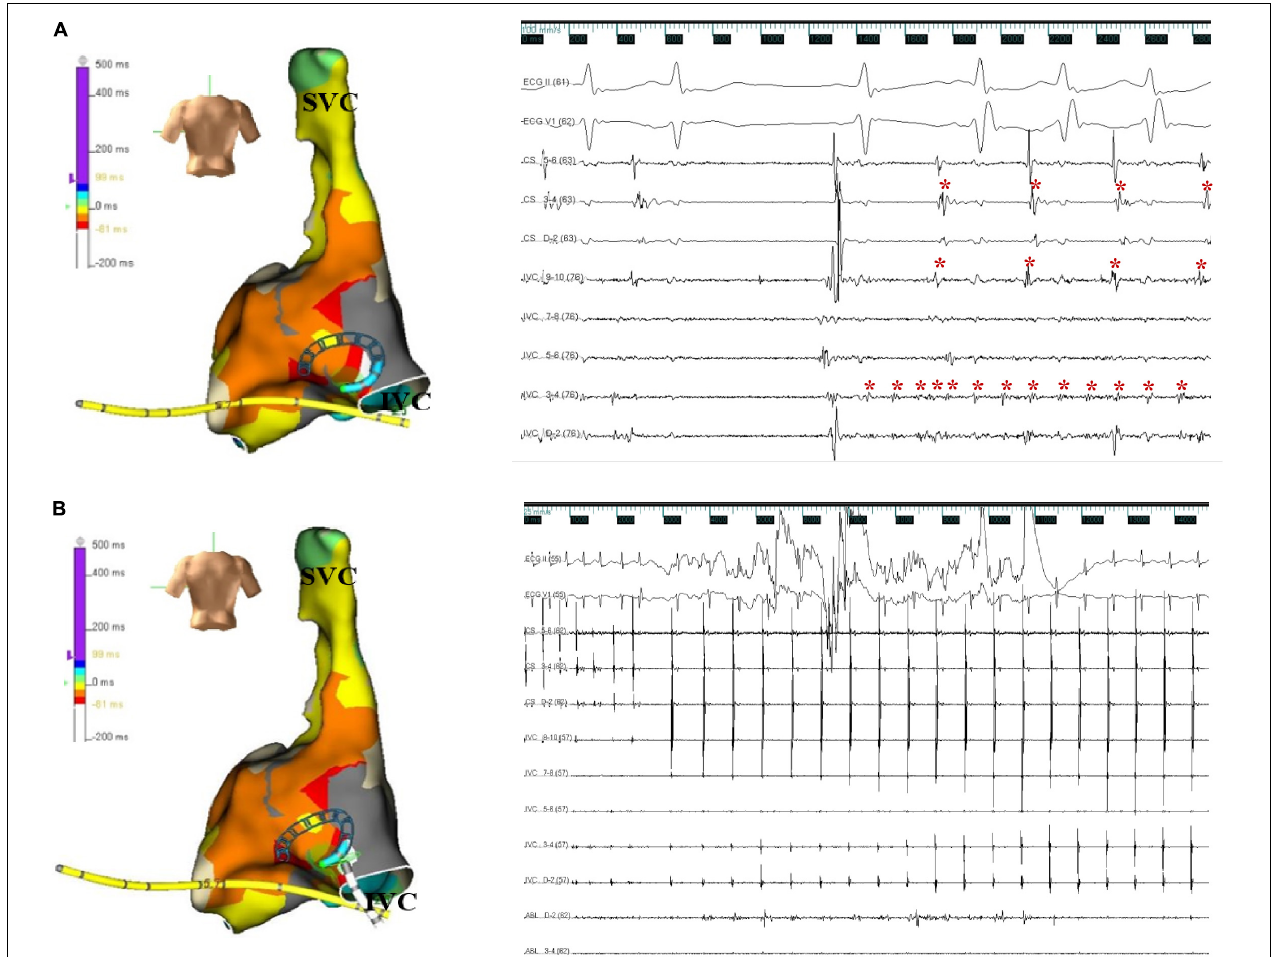
FIGURE 3 | (A) Activation map and electrograms. Activation mapping shows that the earliest activity was at the posteromedial wall of the inferior vena cava. The intracardiac electrocardiogram indicates rapid discharges from the inferior vena cava; some of them were conducted to the right atrium (IVC 9-10) and left atrium (CS). The red asterisk represents the electrical activation recorded by the electrode. The ECG was recorded at a speed of 100 mm/s. (B) Successful ablation site. Atrial fibrillation terminated immediately after radiofrequency ablation at the earliest activation site in the posteromedial inferior vena cava. The ECG was recorded at a speed of 25 mm/s. X axis, time line; y axis, gain. CS, coronary sinus; ECG, electrocardiogram; IVC, inferior vena cava; SVC, superior vena cava.